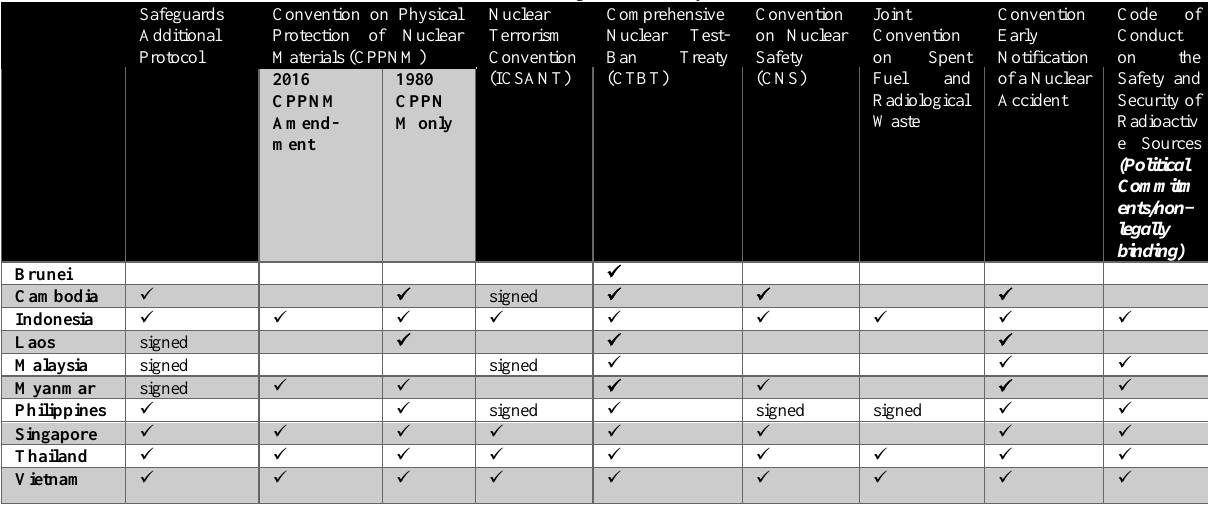
Table 3. ASEAN Member-States’ Participation in Key Nuclear Agreements [ 32 – 35 ]